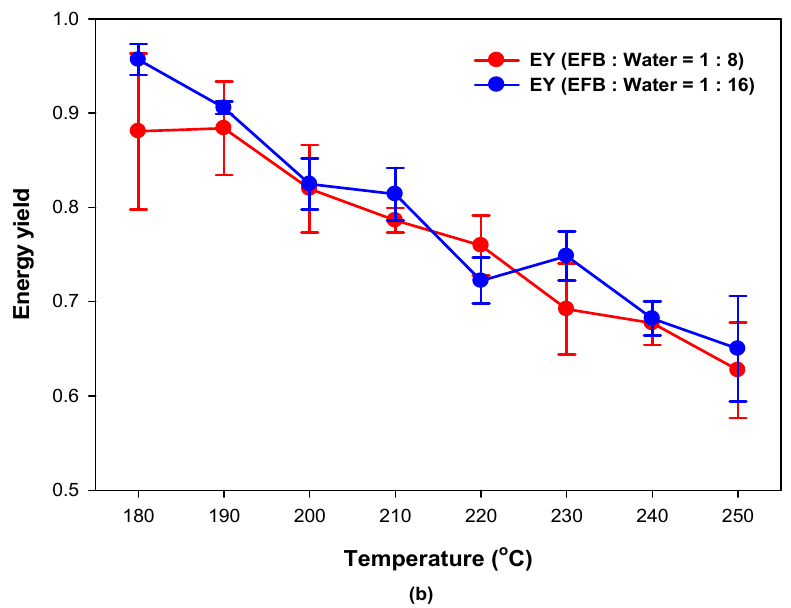
Figure 2. ( a ) HHV, Mass yield (MY), and ( b ) energy yield (EY) of EFB according to reaction temperature and water content.